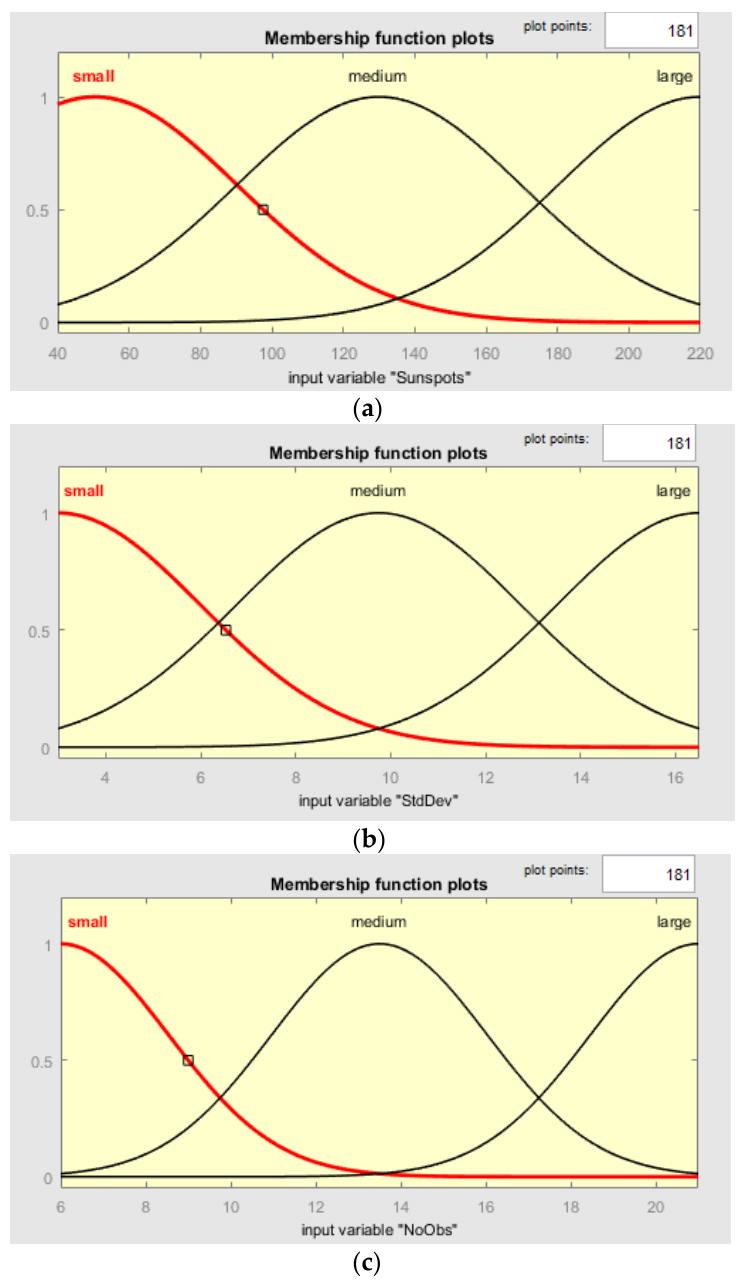
Figure 3. The shape of the membership function for input variables 𝑥 1 ( a ), 𝑥 2 ( b ), 𝑥 3 ( c ) (Own study in MATLAB Fuzzy Logic Toolbox). Each curve represents the degree of belonging of a given linguistic variable to a function. The x -axis (horizontal) specifies a range of values for each variable, e.g., the number of sunspots ranges from 40 to 220. The y -axis values, in turn, range from 0 to 1 and represent the severity of the phenomenon, e.g., the value of 100 sunspots is small with probability 0.5, medium with probability 0.7, and large with probability